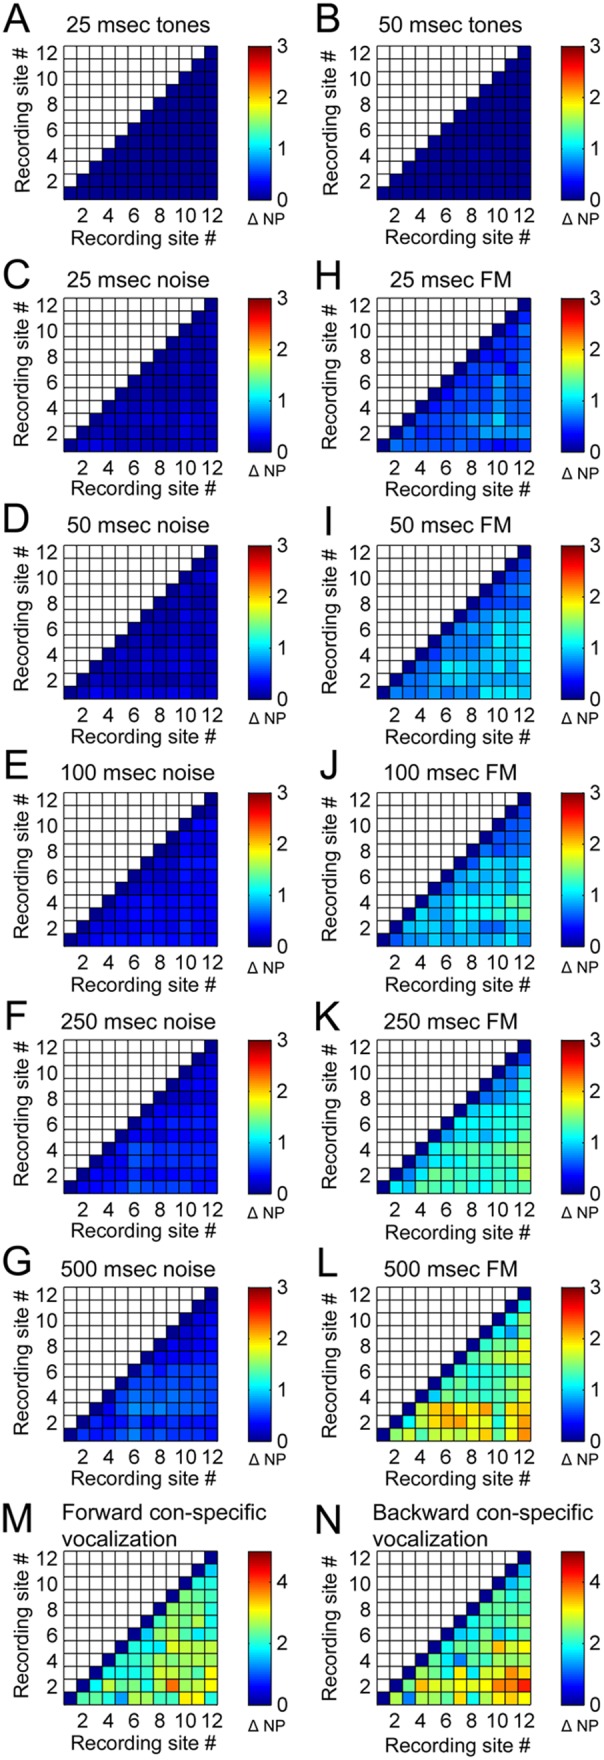
Mean difference in number of PSTH peak responses between neuronal recordings within primary auditory cortex columns.
A–B. Difference in number of PSTH peak responses during pure tone exposure. 25-ms (A), and 50-ms (B). C–G. Difference in number of PSTH peak responses during white noise burst exposure. 25-ms (C), 50-ms (D) 100-ms (E), 250-ms (F), and 500-ms (G). H–L. Difference in number of PSTH peak responses during upward FM sweep exposure. 25-ms (H), 50-ms (I) 100-ms (J), 250-ms (K), and 500-ms (L). M–N. Difference in number of PSTH peak responses during con-specific vocalization. Forward (M), time-reversed (N). Note the progressive increase in dissimilarity between responses as a function of acoustic signal duration during FM sweep exposure. Peak variability indices varied between 0 and 5, with an index value of 0 corresponding to no variations in the number of peak responses (diagonal) and a value of 5 representing the largest mean difference in peak response numbers measured. Numbers in color table axes correspond to recording site numbers, see Fig. 1 for electrode site description. NP: number of peaks.